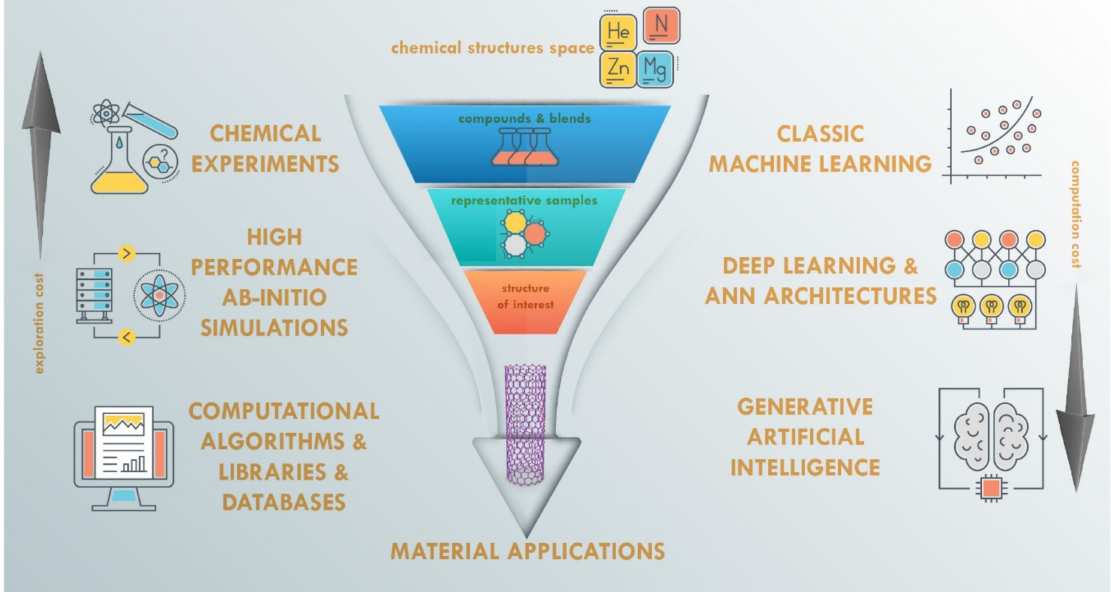
Figure 3. Computerized and AI-equipped approaches in materials